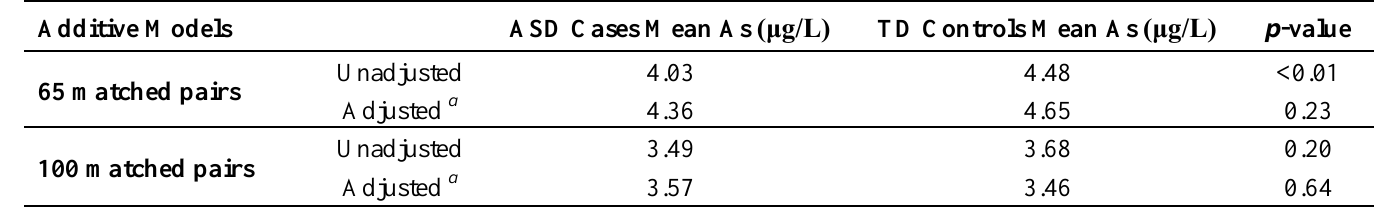
Table 4. Unadjusted and adjusted mean blood arsenic concentrations for ASD cases and their matched TD controls based on General Linear Models (GLM) based on 65 and 100 matched